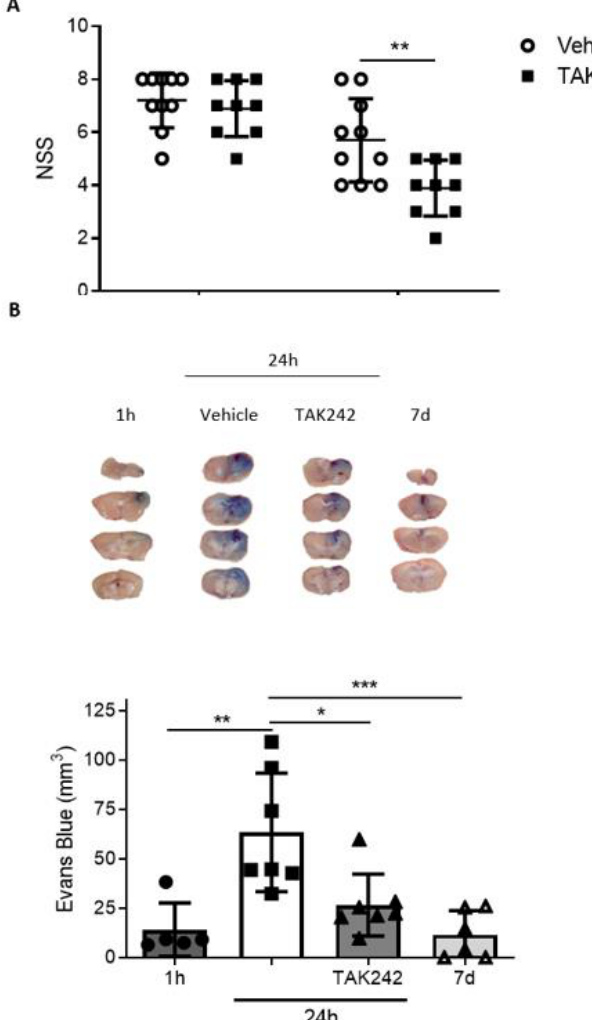
Figure 7. TAK242 improves NSS score and Blood–Brain Barrier (BBB) impairment produced by trauma. ( A ) Immediately following the 1-h NSS test, mice were treated with vehicle solution (0.9% NaCl) or TAK242 (3 mg/kg). NSS was repeated in the same mice 1 d.a.i (vehicle, n = 10; TAK, n = 8). ** p < 0.01, 2-way ANOVA with Sidak’s multiple comparisons test. ( B ) Mice were injected intraperitoneally with Evans Blue dye (2%) after the 1-h NSS test in vehicle and TAK242 groups and were sacrificed 24 h later. For 1 h group, it was injected immediately after TBI. For 7 d group, Evans Blue was injected the day before sacrifice. Brains were cut in 2 mm slices to analyze the stained brain surface (1 h, n = 5; vehicle, n = 7; TAK242, n = 7; 7 d, n = 6). * p < 0.05, ** p < 0.01, *** p < 0.001, 1-way ANOVA with Tukey’s multiple comparisons test. Representative photographs of the four 2-mm slices obtained in each brain are shown above the graph.